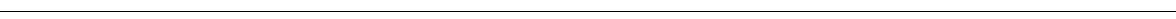
Fig. 1 Development of the Fer/FerT kinase inhibitor-E260 by using a yeast-based HTS system. a Native Fer (pAES-Fer) and a mutated kinase inactive Fer (pAES-FerY715F) were expressed in yeast cells using the pAES expression vector. Protein lysates from transfected cells were subjected to WB analysis using anti-HA (for HA-tagged Fer), anti-Fer, anti-phosphotyrosine (p-tyr), and anti-actin antibodies. b Growth curve of yeast cells expressing either the empty pAES vector, native Fer, inactive Fer, and non-transformed yeast cells; n = 3, ± SE. c Scheme of the HTS program. d The chemical structure the 0342 compound. e The chemical structure of the E260 compound. f Growth curve of yeast transformed with the different plasmids and treated with either DMSO, 2 µ M E260, or 2 µ M 0342. pAES-harboring cells treated with DMSO, mutant Fer treated with DMSO, native Fer-expressing cells treated with DMSO, native Fer-expressing cells treated with 0342, native Fer-expressing cells treated with E260. Untransformed yeast cells served as a negative control; n = 3, ± SE. g Histograms depicting the 600 nm OD readings of the yeast growth-curves (presented in f ) after 40 h; n = 3, ± SE. h Protein lysates prepared from yeast expressing mutant Fer and treated with DMSO for 24 h (pAES-FerY715F), active Fer and treated with 2 µ M E260 (pAES-Fer E260), active Fer and treated with DMSO (pAES-Fer DMSO), or harboring the pAES vector alone and treated with DMSO, were subjected to WB analysis using anti-Fer, anti-p-tyr, and anti-PGK antibodies. Arrow on the right depicts the MW of Fer. This image presents one experiment representative of three, which gave similar